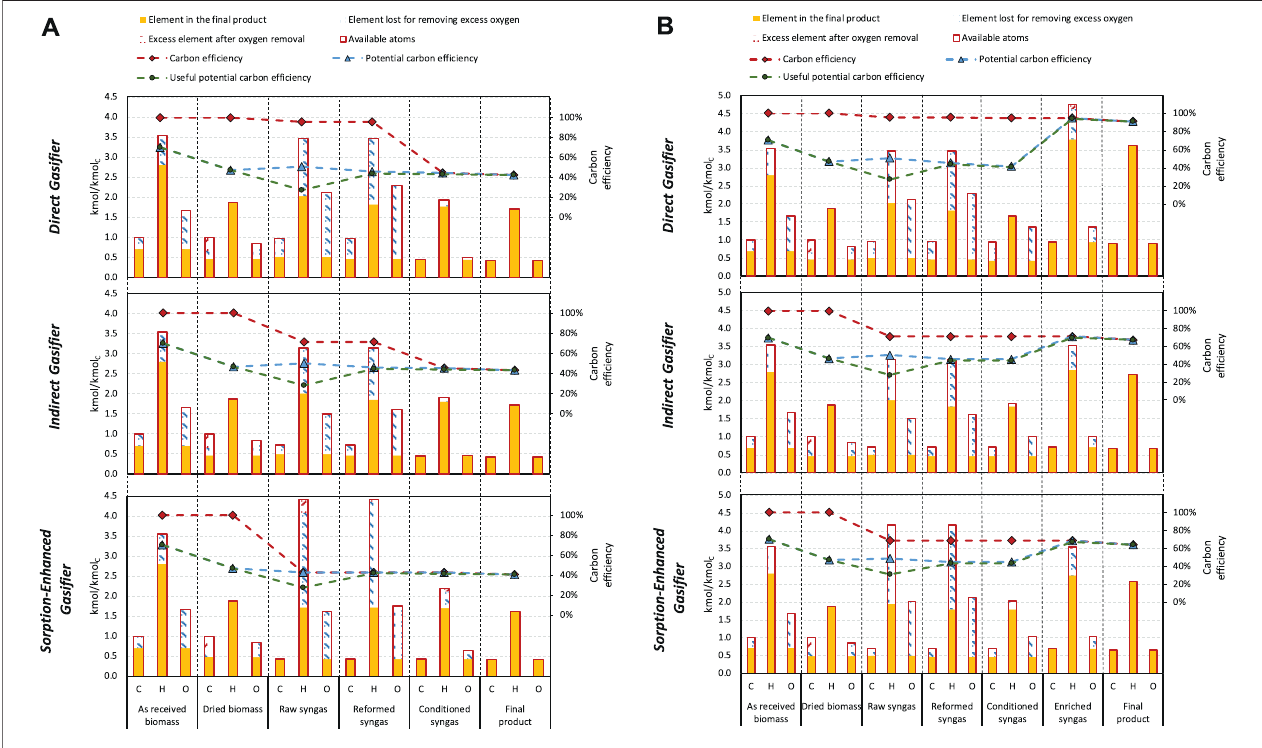
FIGURE 7 | Carbon ef fi ciency, potential carbon ef fi ciency, and useful potential carbon ef fi ciency of the process in baseline (A) and enhanced operation (B) for the direct, indirect, and sorption-enhanced gasi fi cation-based plants.